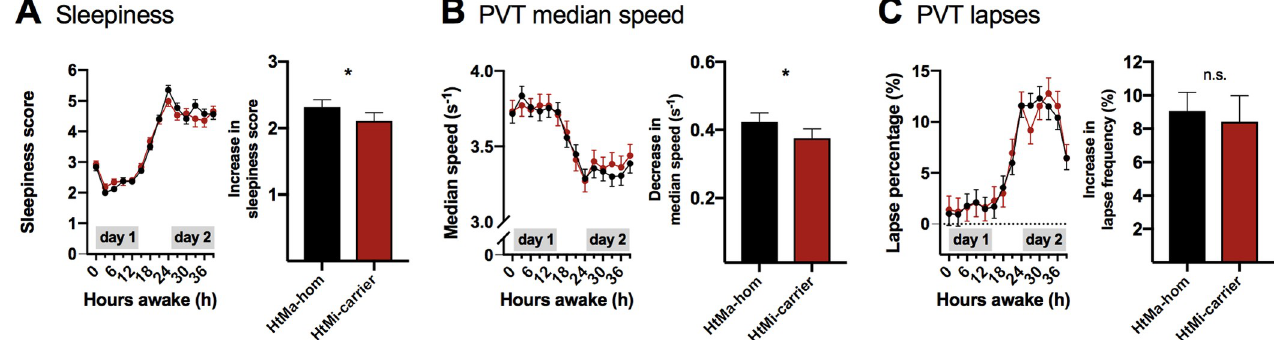
Fig 4. Objective and subjective measures of sleep deprivation is affected by the AQP4 haplotype. Subjective sleepiness ratings on the SSS and objective alertness measures by the PVT. SSS scores (A), median speed (B), and attention lapses (C) on the PVT were quantified at 3-hour intervals across the 40 hours of prolonged wakefulness. Three-way linear mixed-model analysis revealed strong differences between day 1 and day 2 (“day”: F all > 442, p < 0.0001) and moderate modulations of clock time (F all > 4.6, p < 0.0005) and by the “day x clock time” interaction (F all > 3.5, p < 0.004) in all 3 measures. Comparison of subjective sleepiness between the 71 HtMa homozygotes (black) and the 52 HtMi carriers (red) of the AQP4 haplotype revealed that the HtMi group coped slightly better with prolonged wakefulness than the HtMa homozygotes (“haplotype x day”: F 1,364 = 4.5; P < 0.04; η p2 = 1.22%; Panel A right). Intriguingly, the AQP4 -haplotype dependent modulation of sleepiness was mirrored by a similar effect on PVT median speed performance among the 60 HtMa homozygotes and 44 HtMi carriers that were tested (“haplotype x day”: F 1,1041 = 4.7; P < 0.04; η p2 = 0.45%; Panel B right), an effect similar yet not significant for lapses of attention (“haplotype x day”: F 1,1041 = 0.1, p > 0.78, Panel C right; S4 Data). Data represent estimated mean ± SEM. � p < 0.05 from the corresponding “haplotype x day” interaction. AQP4, aquaporin 4; hom: Homozygote; HtMa, Major allele of haplotype; HtMi, Minor allele of haplotype; PVT, psychomotor vigilance test; SSS, Stanford sleepiness